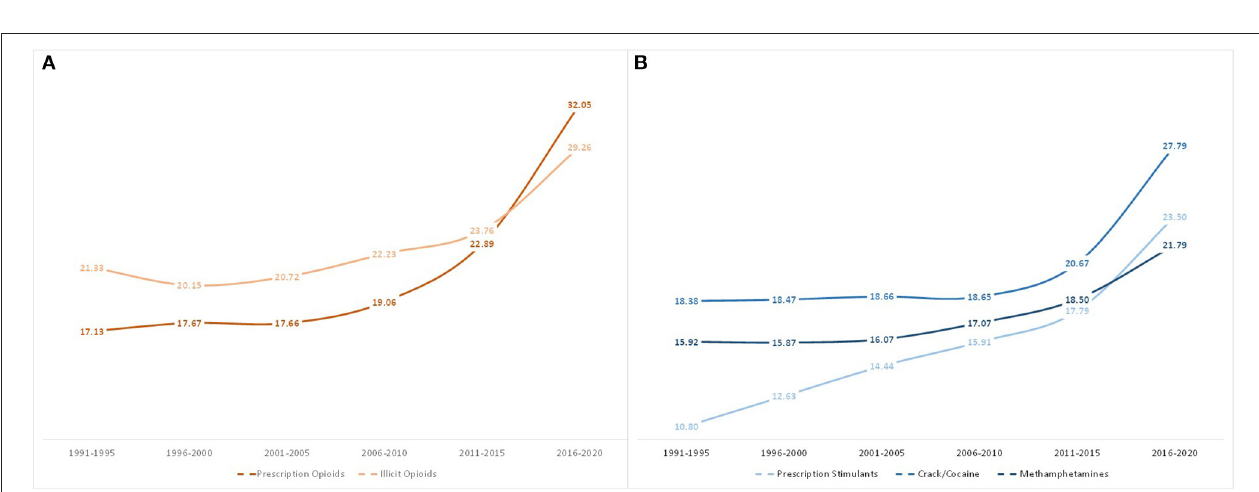
FIGURE 6 | Mean age of first use of opioids or stimulants when used as the initial drug of exposure, grouped by year of initial drug